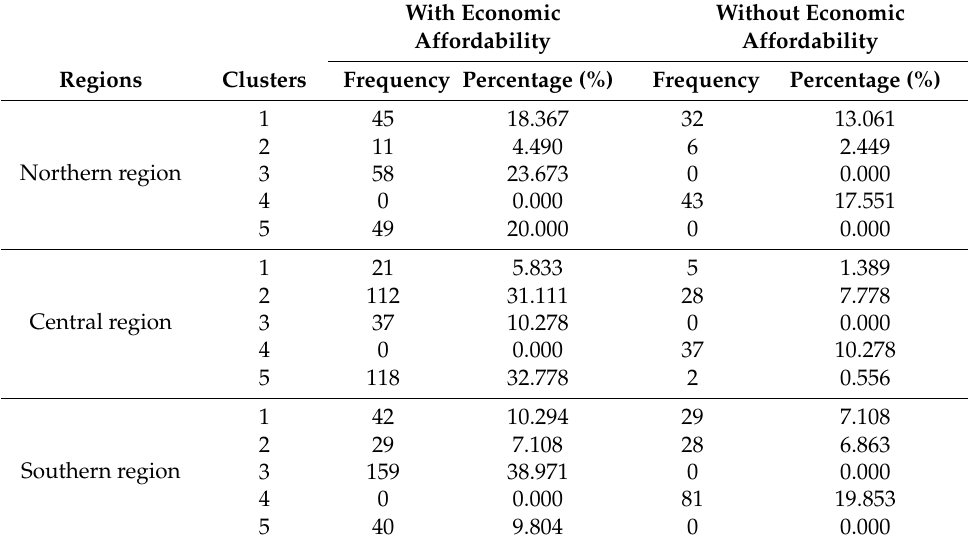
Table 6. Impact of drought on farmer livelihood